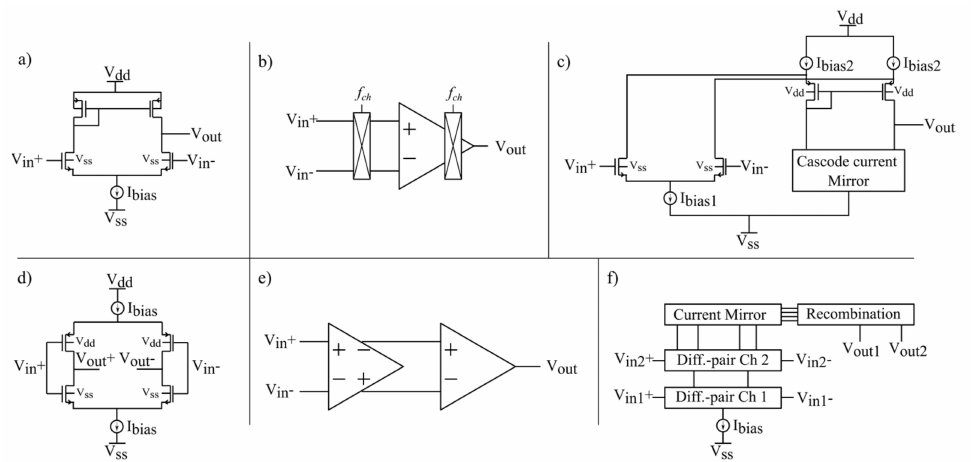
Figure 1. Exemplary configuration of the conceptually different approaches of low-power and low-noise amplification for biomedical applications: ( a ) conventional OTA with a differential input pair, a current mirror as load, and a bias current soure I bias . ( b ) Chopper-stabilized amplifier with the chopping frequency f ch . ( c ) Folded-cascode amplifier with a differential input pair in parallel to the cascoded current mirror, operating as high impedance load. ( d ) Inverter-based amplifier with complementary transistors on the left and right side, respectively, each pair forming an inverter. ( e ) Simple schematic of a multistage amplifier. ( f ) Current-reuse amplifier with an input pair for each channel (marked as Diff.-pair), a current mirror stage, and a recombination stage, which forms the output signal